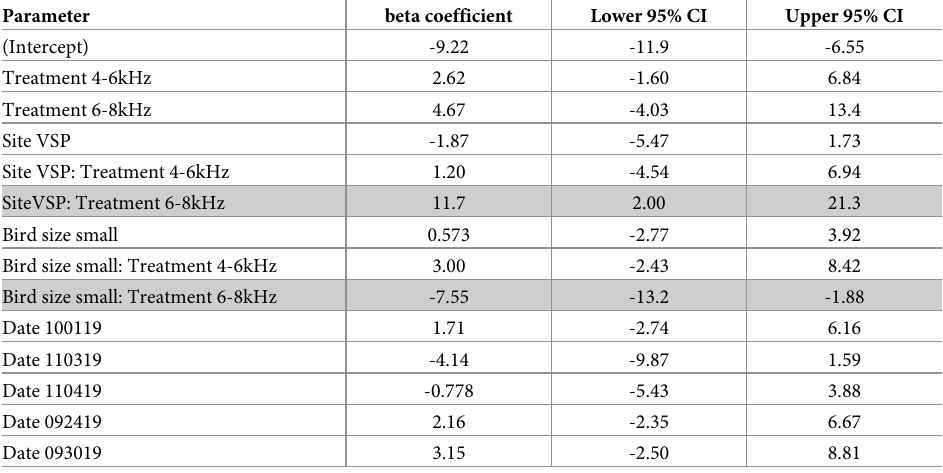
Subset of all model-averaged parameter estimates based on a-priori interest and parameter importance. Treatment refers to the effects of the two sound ranges. Site refers to the VSP tower location. Bird size refers to the small bird size class. Date refers to the date (month-day-year) of observations. Parameter estimates with 95% confidence intervals not overlapping zero are highlighted in gray.